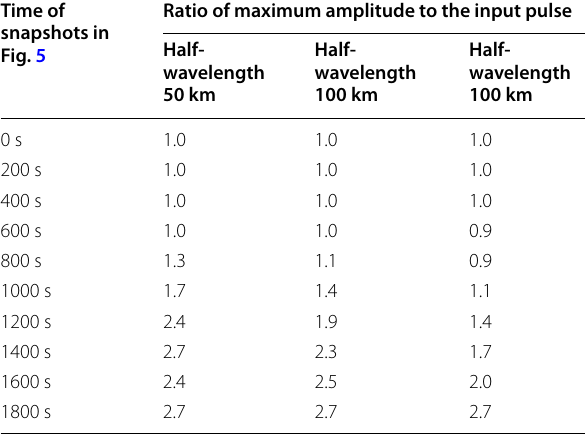
the eruption at the Hunga Tonga-Hunga Ha ʻ apai volcano and propagated through the Pacific should be properly modeled as a future study.